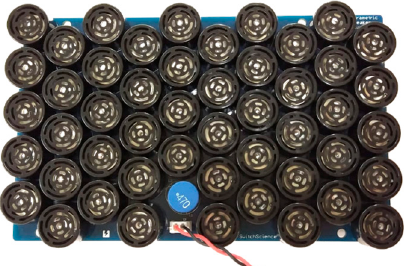
Figure 1. Ultrasonic array employed for the parametric speaker made of 49 ultrasonic transducers of 16 mm diameter.